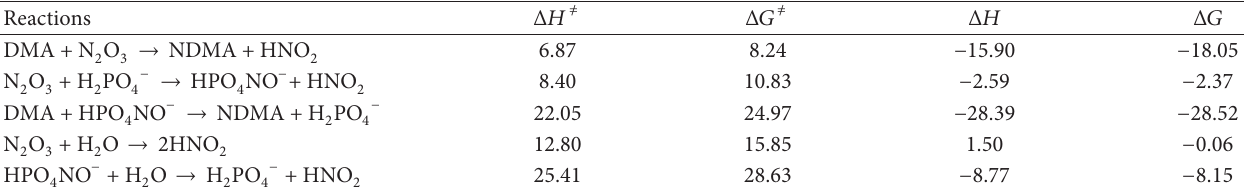
T 2: Calculated activation energies and reaction energies (in kcal/mol) for possible reactions involved in the phosphate-buffered “DMA ” reaction system at the B3LYP/6-311+G(d,p) level. + NO 2−